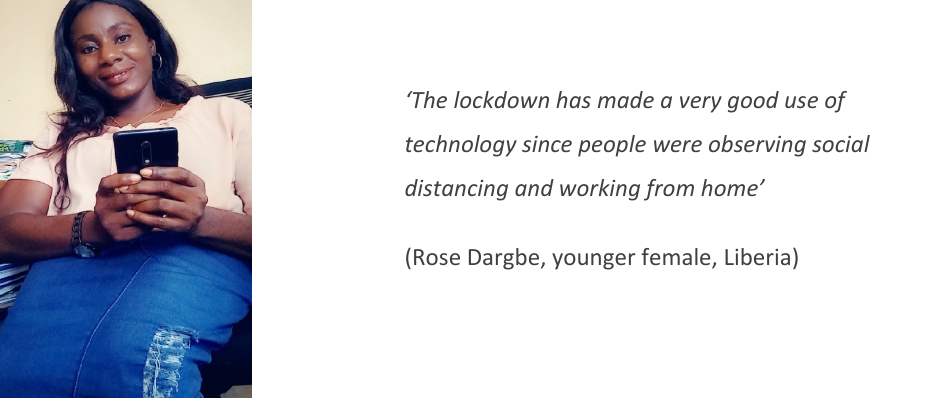
‘The lockdown has made a very good use of technology since people were observing social